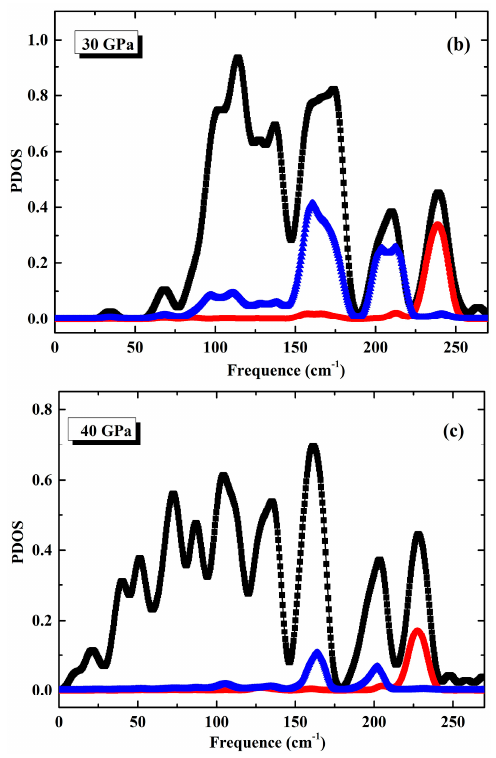
Figure 3. The partial phonon density of state of K 8 Si 46 at ( a ) 0 GPa; ( b ) 30 GPa and ( c ) 40 GPa.